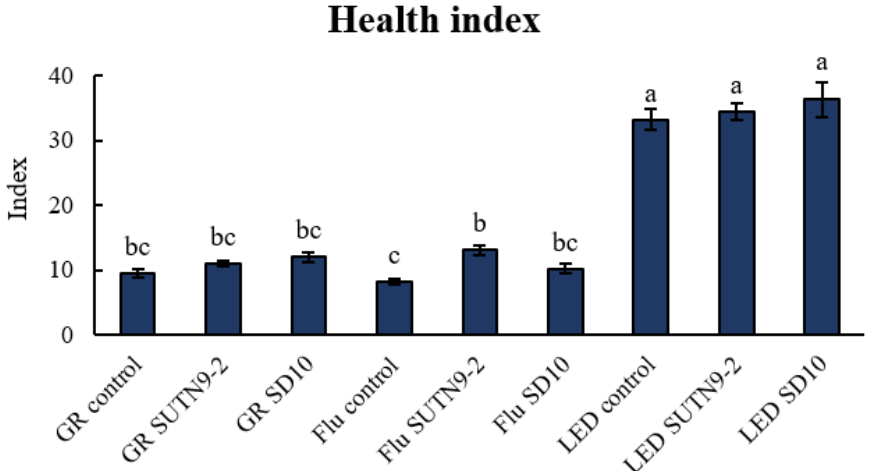
Figure 6. The effect of PGPR inoculation under different lighting conditions on the tomato seedling health index. The tomato seedlings were recorded at 14 days after planting. Mean and standard error are calculated from four replicates. Values with different letters in each treatment differed significantly at p ≥ 0.05. GR: tomatoes planted under greenhouse conditions, Flu: tomatoes planted under fluorescent light (150 µmol/m 2 /s, exposed for 18 h/day), LED: tomatoes planted under LED light (200 µmol/m 2 /s, ratio R60:B40, exposed for 20 h/d).